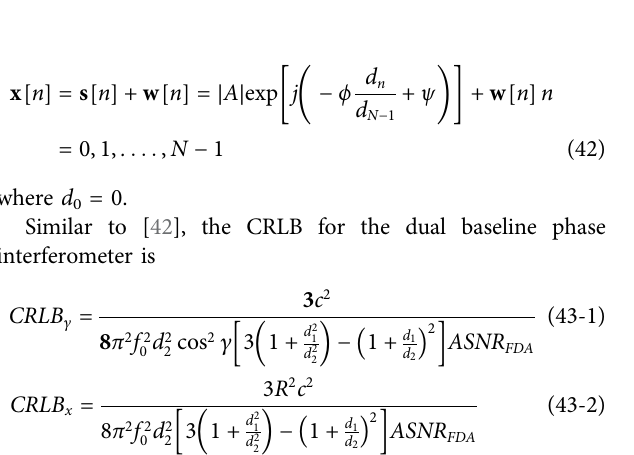
FIGURE 6 | The DOA deception effect of the FDA (A) x -intercept deviation with f 0 (B) x -intercept deviation with Δ f (C) x -intercept deviation with Q (D) x -intercept deviation with R (E) x -intercept deviation with c (F) x -intercept deviation with t.